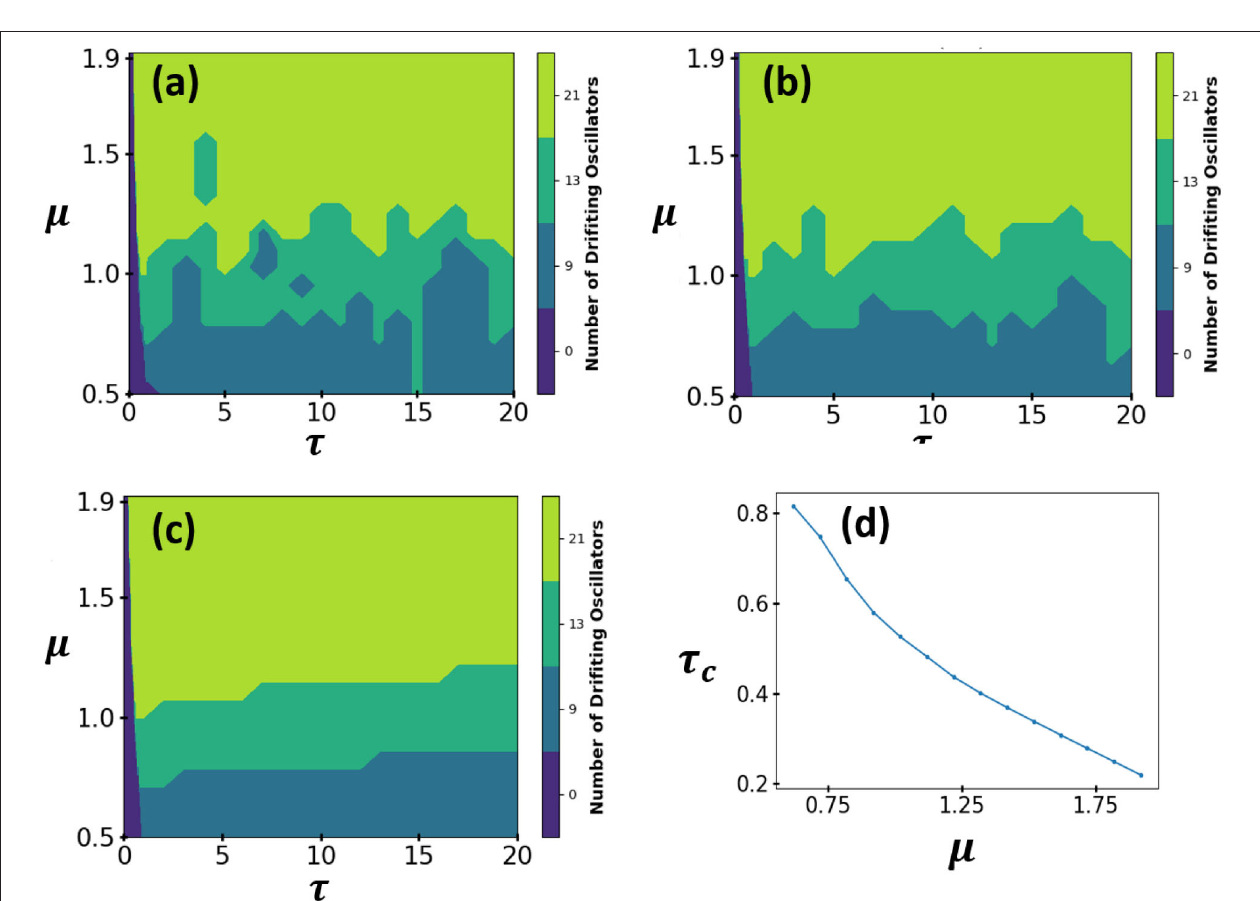
FIGURE 7 | Phase diagrams of 2D lattice in τ and µ parameters space employing (a) KNN, (b) SVM, and (C) MLP-NN algorithm. Here, the region boundaries are determined using a trained machine learning model. These are filled contour plots where each color represents a different value for “number of drifting oscillators” found in the engineered chimera state. (a) Using KNN algorithm: the value of parameter K = 5 for training this model is obtained using validation curve analysis (see Figure 6 ). (b) Using SVM algorithm: RBF kernel are used while training this SVM model. The value of parameters C = 10 and gamma = 0.5 is obtained used grid search analysis. (c) Using MLP-NN algorithm: ReLU activation function is used while training this MLP-NN model. Apart from the input and output layer, the artificial neural network used in this algorithm contains 2 hidden layers with 30 nodes each. (d) The behavior of critical delay as a function of µ for a 2D lattice network. The values of critical delay in this plot are calculated using a trained MLP-NN machine learning